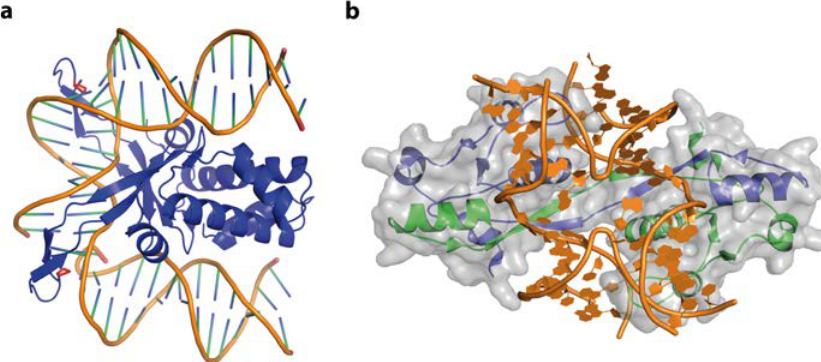
Figure 12. DNA-binding by IHF and T7 endonuclease I. ( a ) In the IHF-DNA complex (PDB code 1IHF) the DNA is roughly bent, with proline residues (red) intercalating, destacking the base pairs and stabilising the kinked structure. No direct or indirect contacts of IHF with the DNA major groove can be observed; ( b ) Illustration of a Holliday junction bound by T7 Endonuclease I (PDB code 2PFJ). The protein-DNA interactions results in large conformational changes: the duplex arms of the Hj are kinked by 80° and the junction centre is